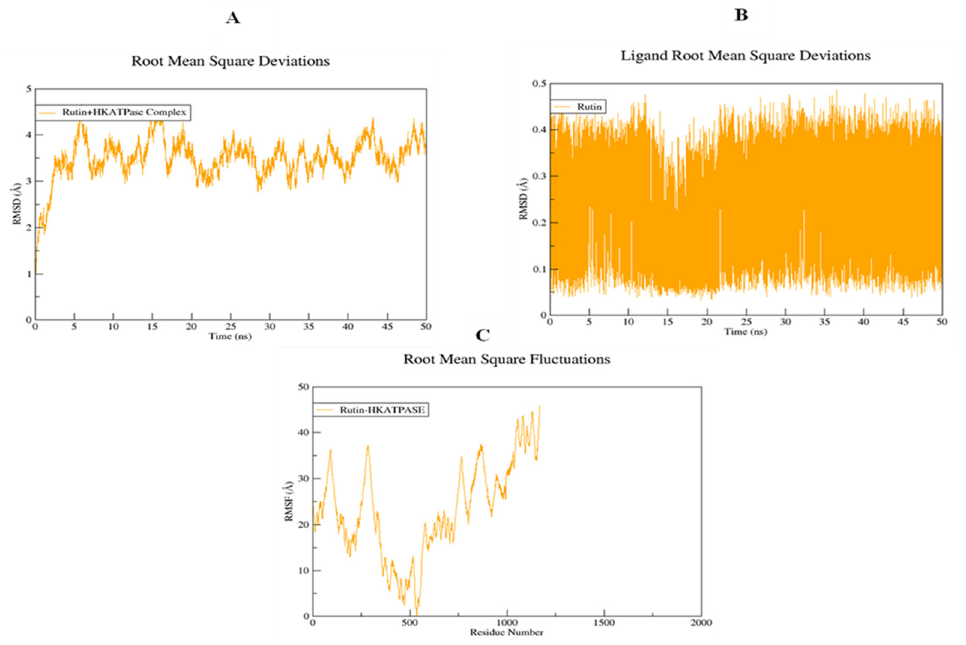
Figure 18. Root mean square deviations of backbone atoms of ( A ) rutin-H + /K + -ATPase docked complex, ( B ) rutin, and ( C ) root mean square fluctuations of the backbone atoms of the rutin-H + /K + - ATPase docked complex.